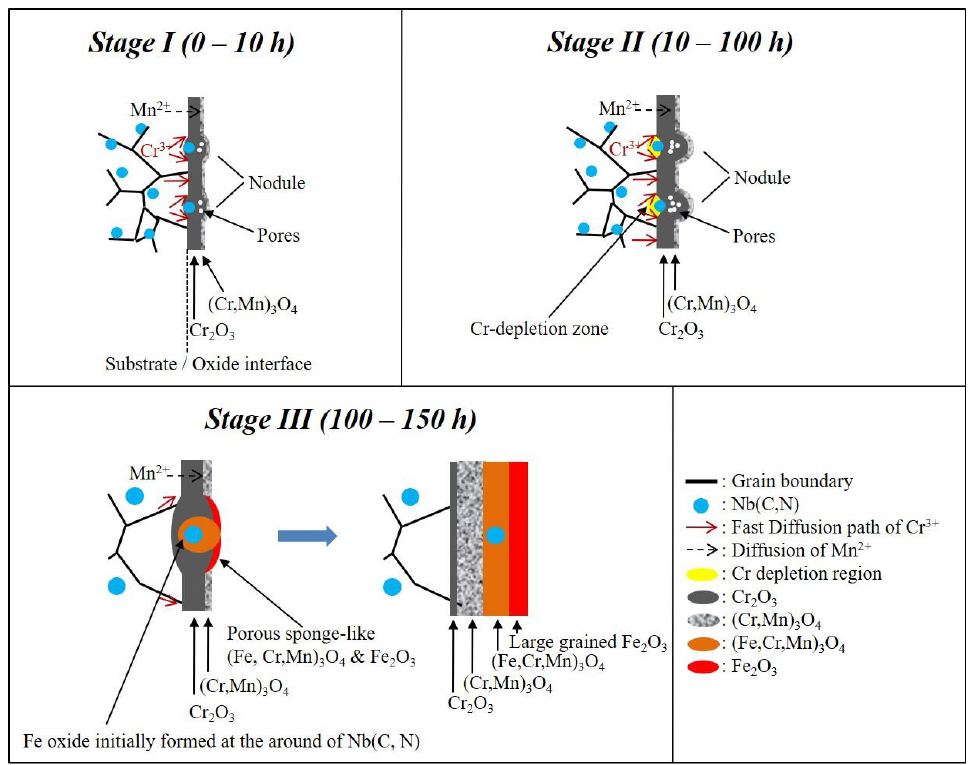
Figure 9. Schematic diagram of the growth stages of the oxide layer around Nb(C, N).